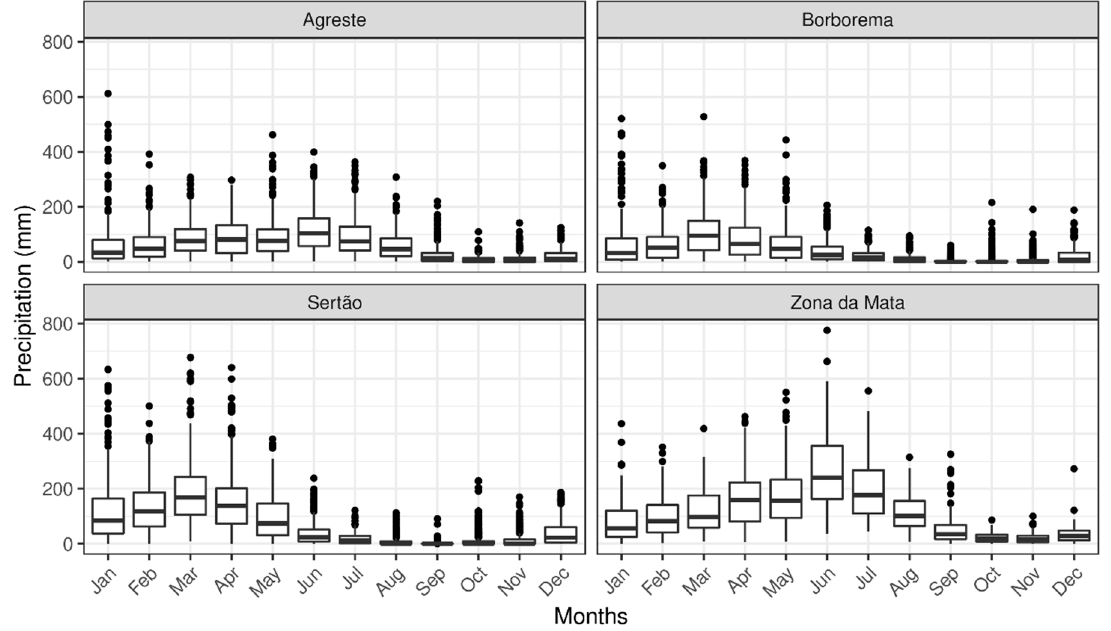
Figure 3. Boxplot for monthly rainfall for the period 1994–2014 in the mesoregions of Zona da Mata, Agreste, Borborema, and Sertão.